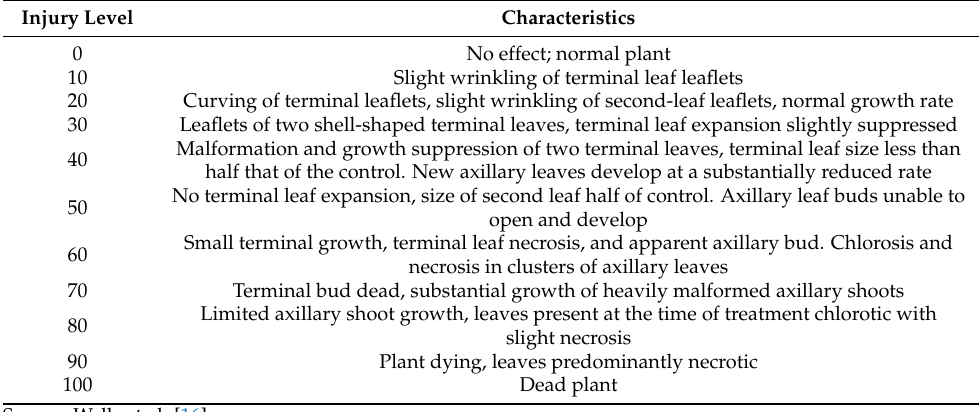
Table 2. Scale used to evaluate the injury level caused by the simulated drift of 2,4-D and dicamba on the tomato